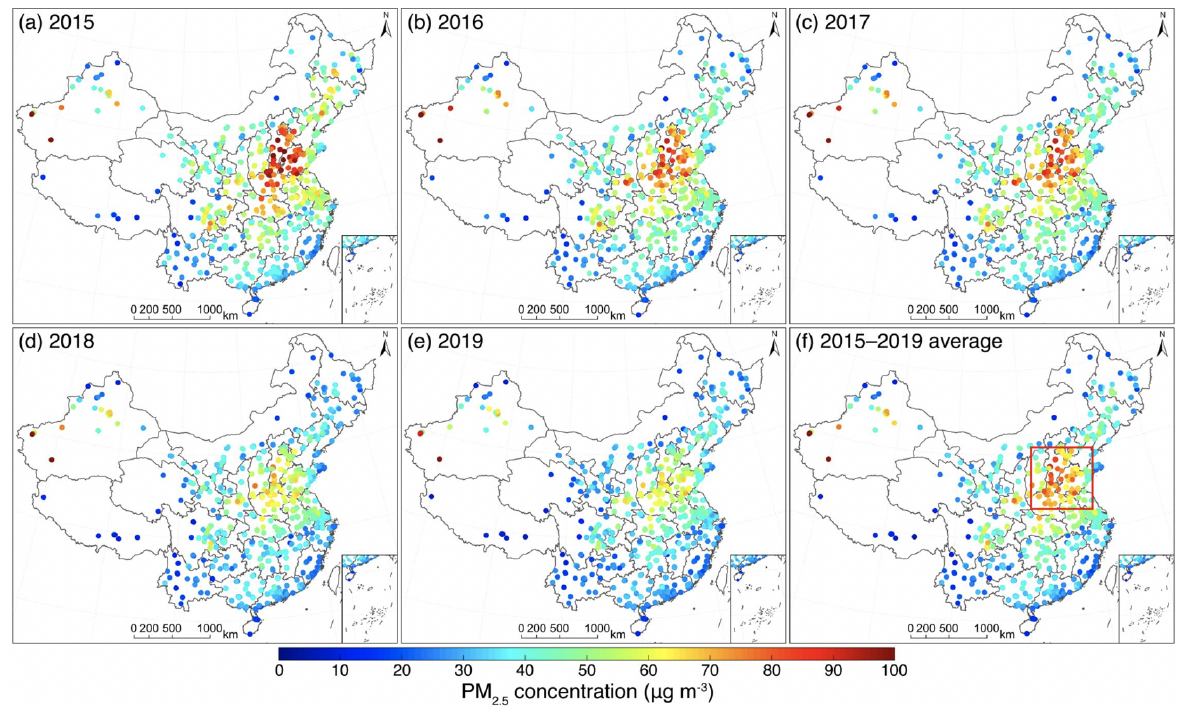
Figure 9. Annual mean PM 2 . 5 concentration derived from the homogenized daily PM 2 . 5 concentration dataset at 1309 monitoring stations between 2015 and 2019. The North China Plain is outlined by the red rectangle in panel (f) .